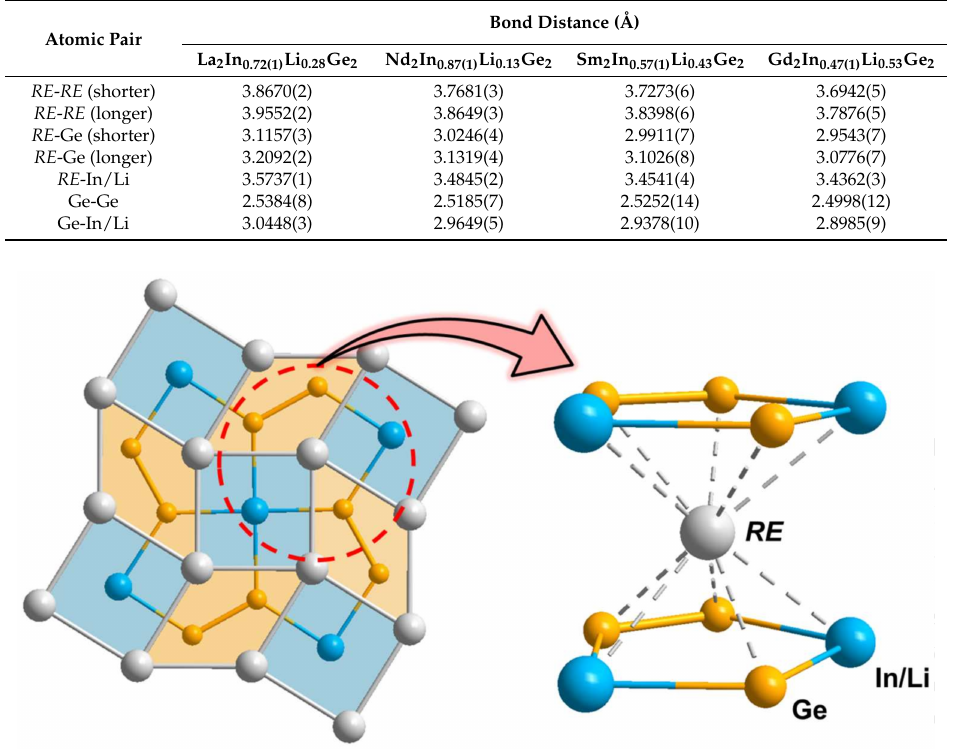
Figure 4. Distorted pentagonal-prismatic coordination environment surrounding a cationic RE site in the RE 2 In 1 − x Li x Ge 2 ( RE = La, Nd, Sm, Gd; x = 0.13(1), 0.28(1), 0.43(1), 0.53(1))